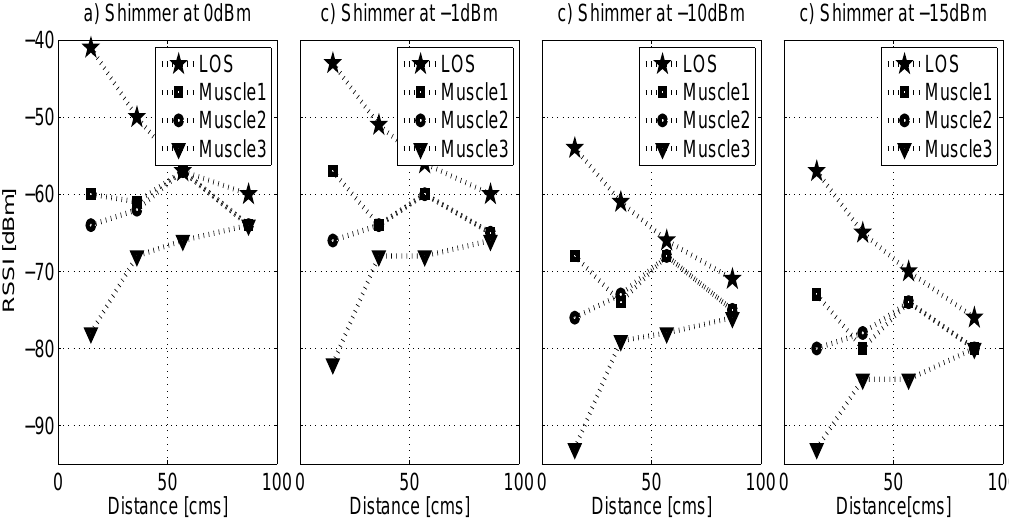
Figure 6. Homogeneous and layered biological tissue: muscle